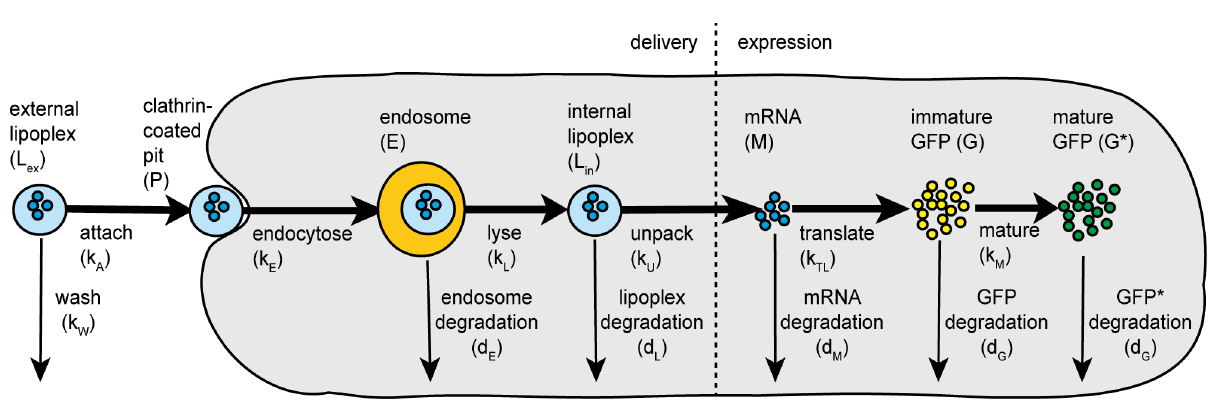
Figure 1. Diagram of the streamlined transfection model. External (extracellular) lipoplexes attach to the surface of the cell, forming clathrin- coated pits, which enter the cell via endocytosis, leading to the formation of endosomes, which either lyse or degrade. This puts the lipoplexes into the cytosol, where they unpack, releasing the mRNA, which translates to unfolded GFP molecules, which then mature (folding and oxidation), to produce active GFP. In addition to the endosomes, the lipoplexes, mRNA, immature and mature GFP are all degraded at set rates.